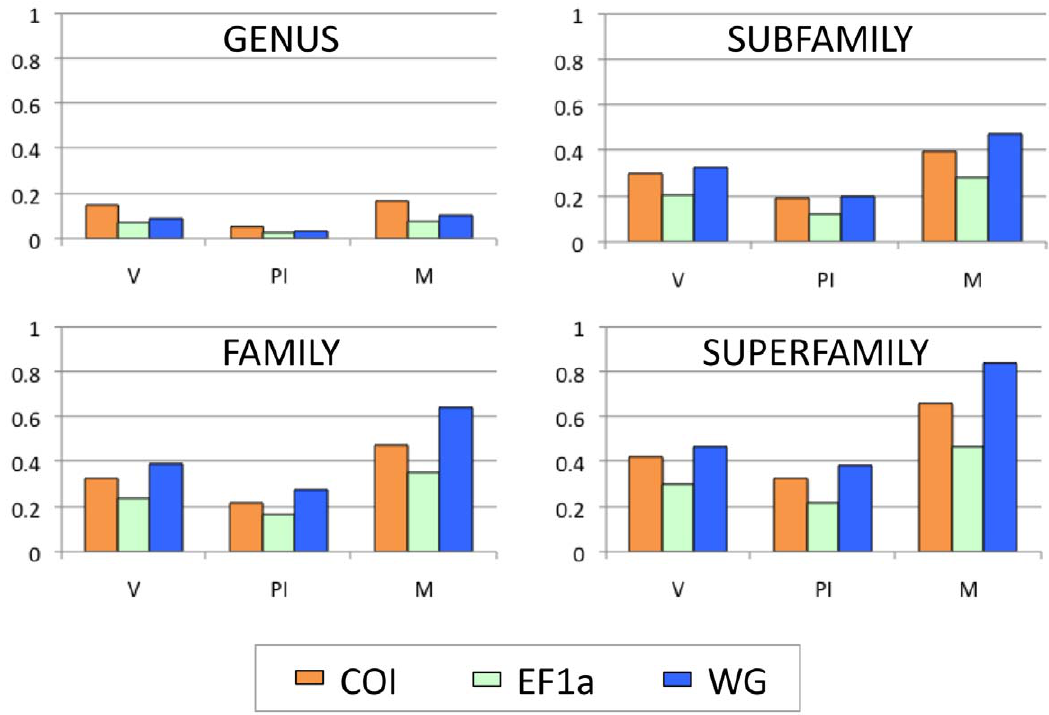
Figure 2. Phylogenetic utility scores. On the y-axes, the proportion refers to A, the aligned sequence length; A was 658 for COI, 1006 for EF1a and 409 for WG. V is the proportion of variable characters, PI is the proportion of parsimony informative characters and M is the proportion of the minimum number of character state changes (see Table 1).